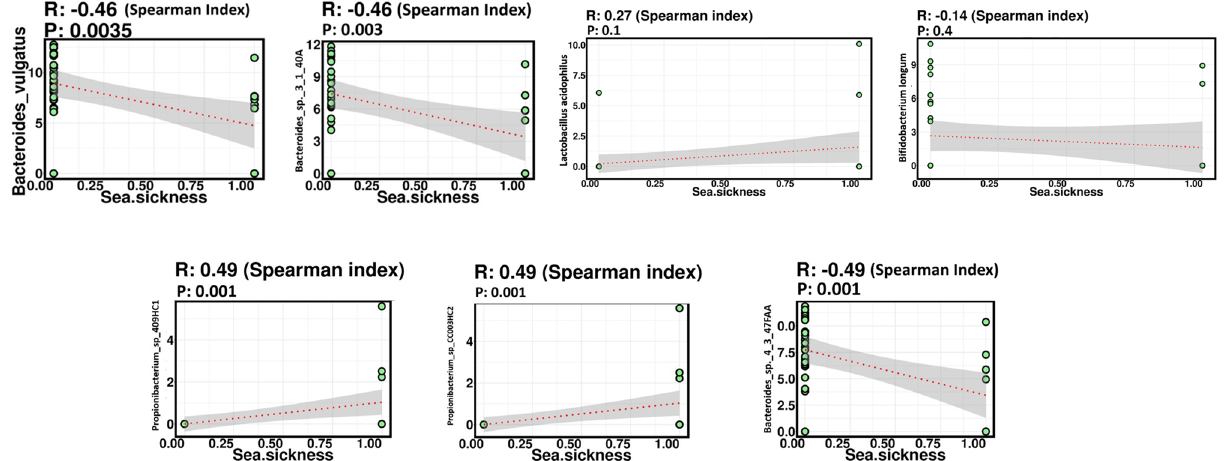
Figure 7. Spearman correlations indicate significant (positive and negative) relationships between microbial species and sea sickness. r: Spearman’s correlation coefficient . Species of genus Propionibacterium (r =